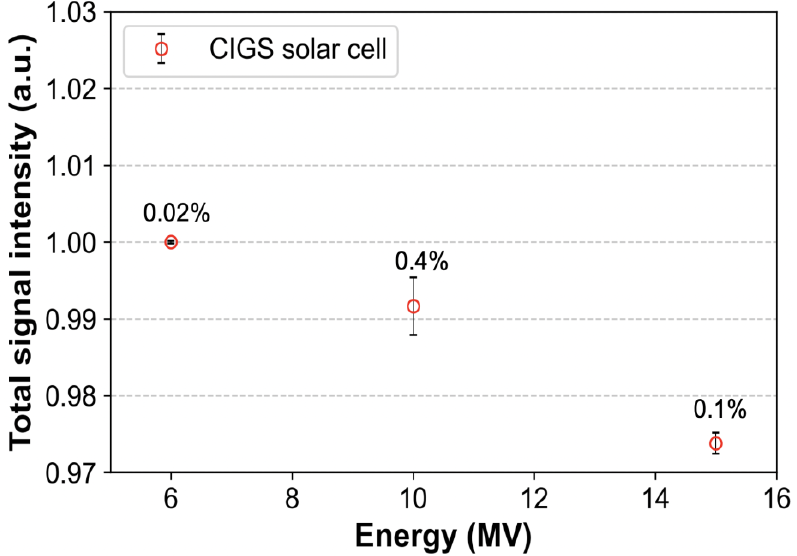
Figure 6. The signals obtained from the copper indium gallium selenide (CIGS) solar cell according to energy changes of the photon beam (6, 10, and 15 MV). Total signal intensity is the sum of the obtained signals from the CIGS solar cell during irradiation. All the signals were normalized based on the signal corresponding to the photon beam energy of 6 MV. Error bars denote the standard deviations (numbers above the error bars) between three repeated measurements.